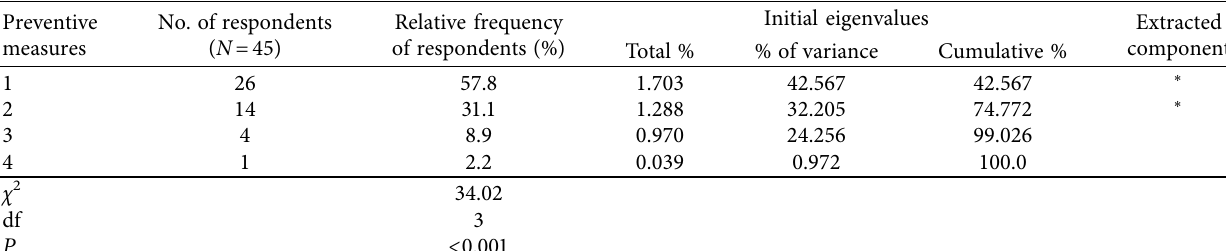
Table 3: Frequency and variance accounted for by different preventive measures of